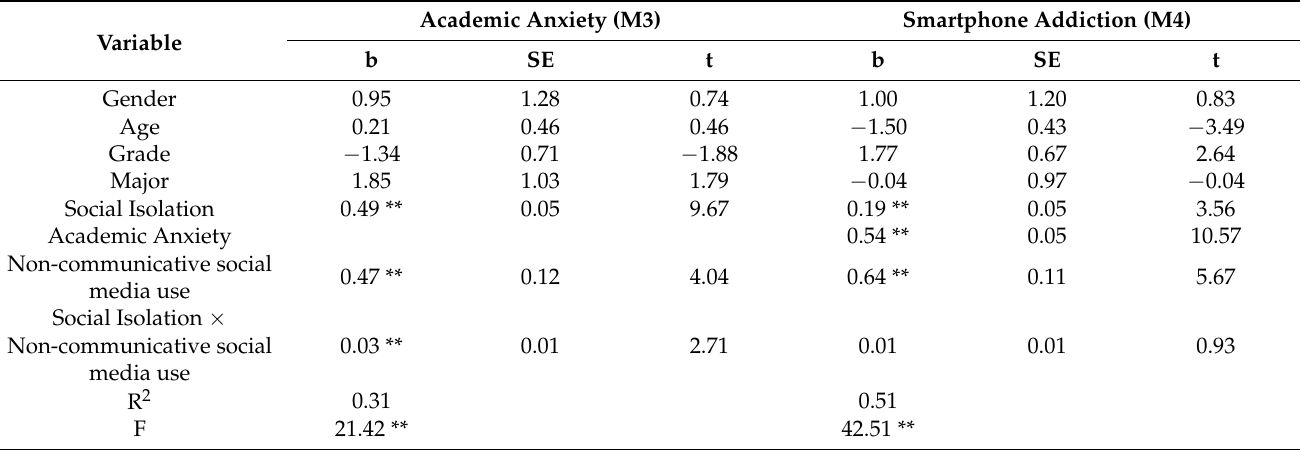
Table 4. Analysis of moderating mediating effects (moderating variables = non-communicative social media